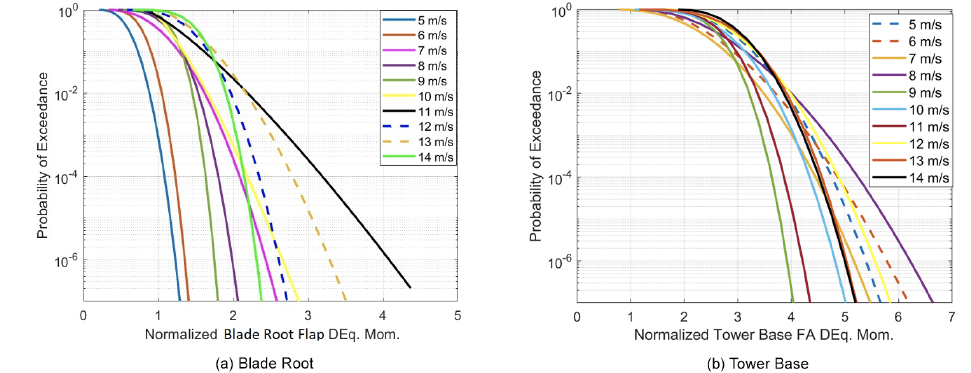
Figure 7. Comparison of the 10min (a) extrapolated blade root flap bending damage equivalent moments and the (b) extrapolated tower base fore–aft damage equivalent moment, using simulations.